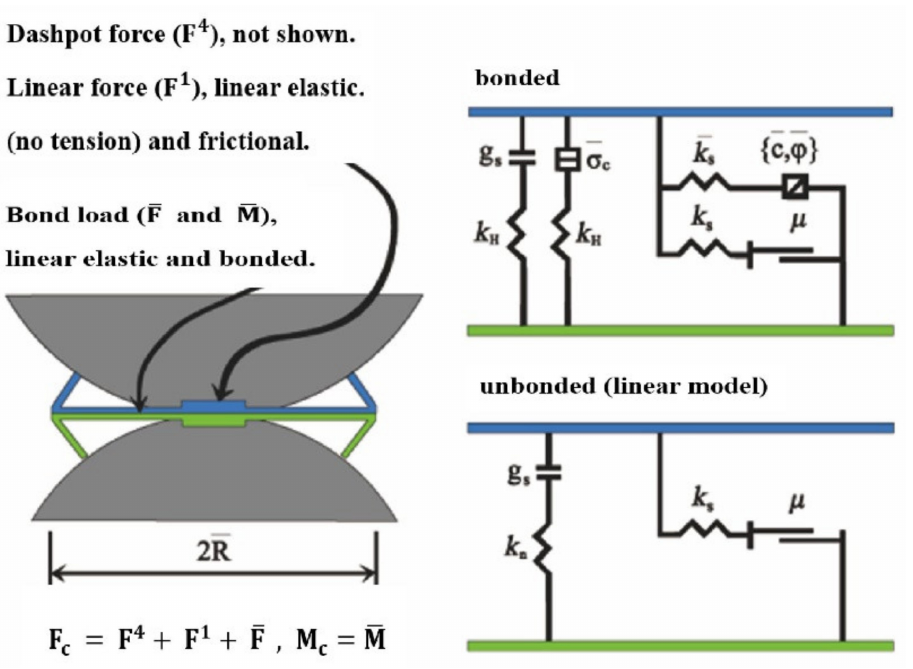
Figure 2. Illustration of the parallel bond